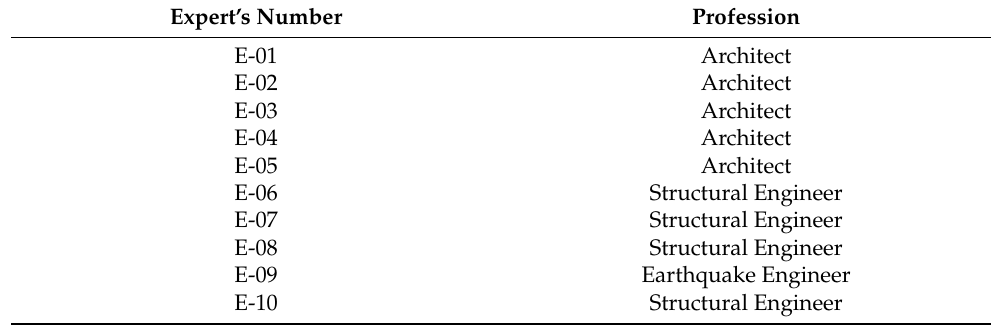
Table 3. Experts’